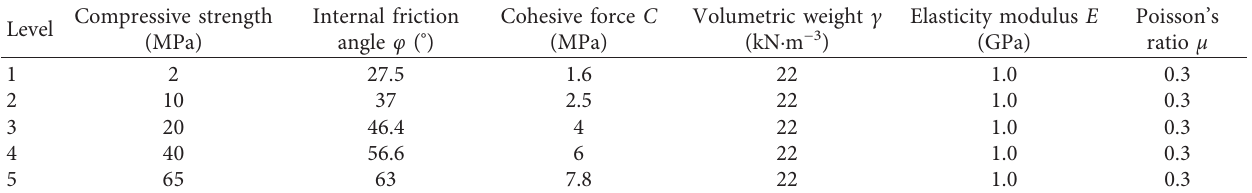
Figure 1: Five types of tunnel cross section. (a) With span of 6m. (b) With span of 9m. (c) With span of 12m. (d) With span of 15m. (e) With span of 18 m. Table 1: Parameter values of each level of factor A.